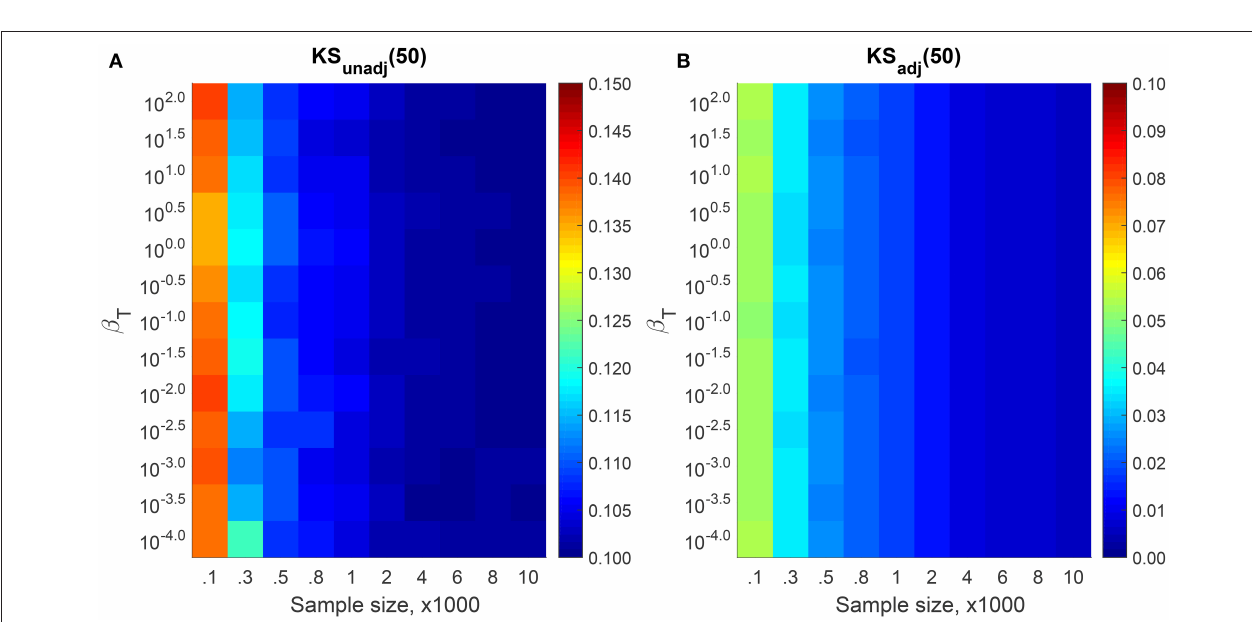
FIGURE 2 | Relative estimation errors of (A) ˆ β unadj and (B) ˆ β adj measured from 1,000 simulated samples using different β T and N with x min x max F − 1 EXP (0.9). Due to the FLE, 1β unadj remains high (close to the theoretical relative error of ǫ ( δ = contrast, 1β adj decreases rapidly with increasing N .